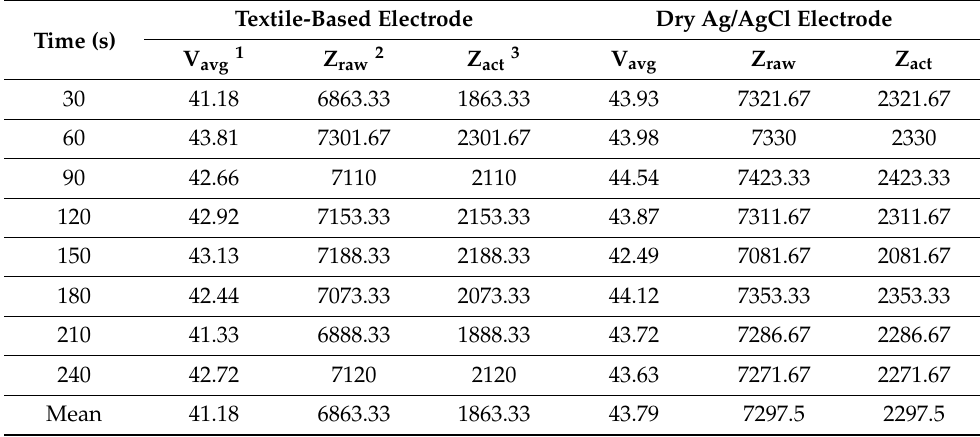
Table 1. The phantom-to-electrode impedance in the EEG alpha band power. Textile-Based Time (s)